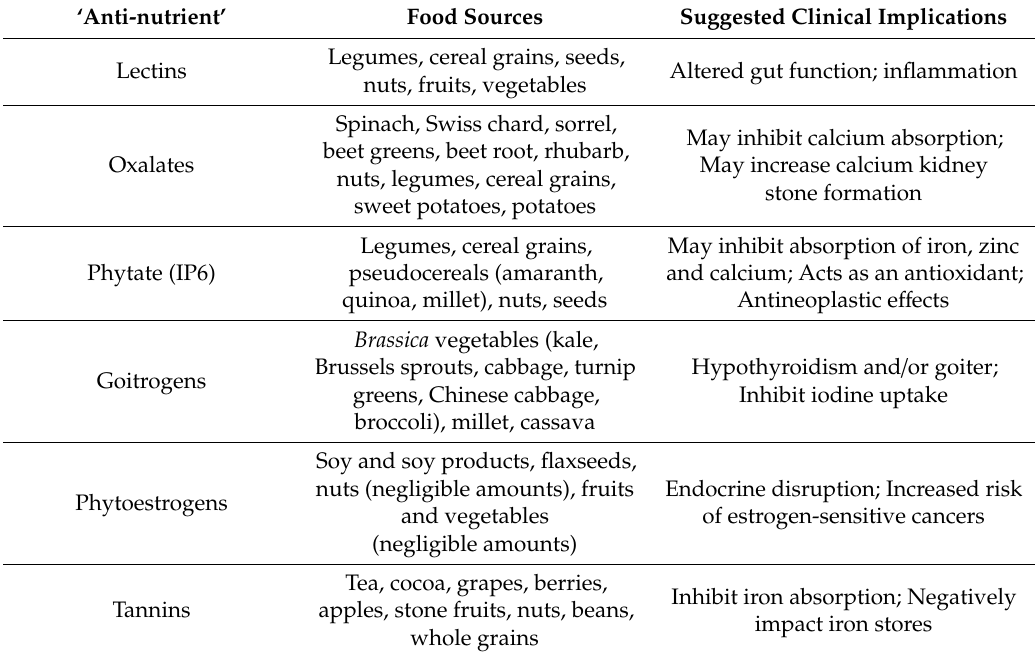
Table 1. Plant Compounds, Food Sources, and Their Suggested Clinical